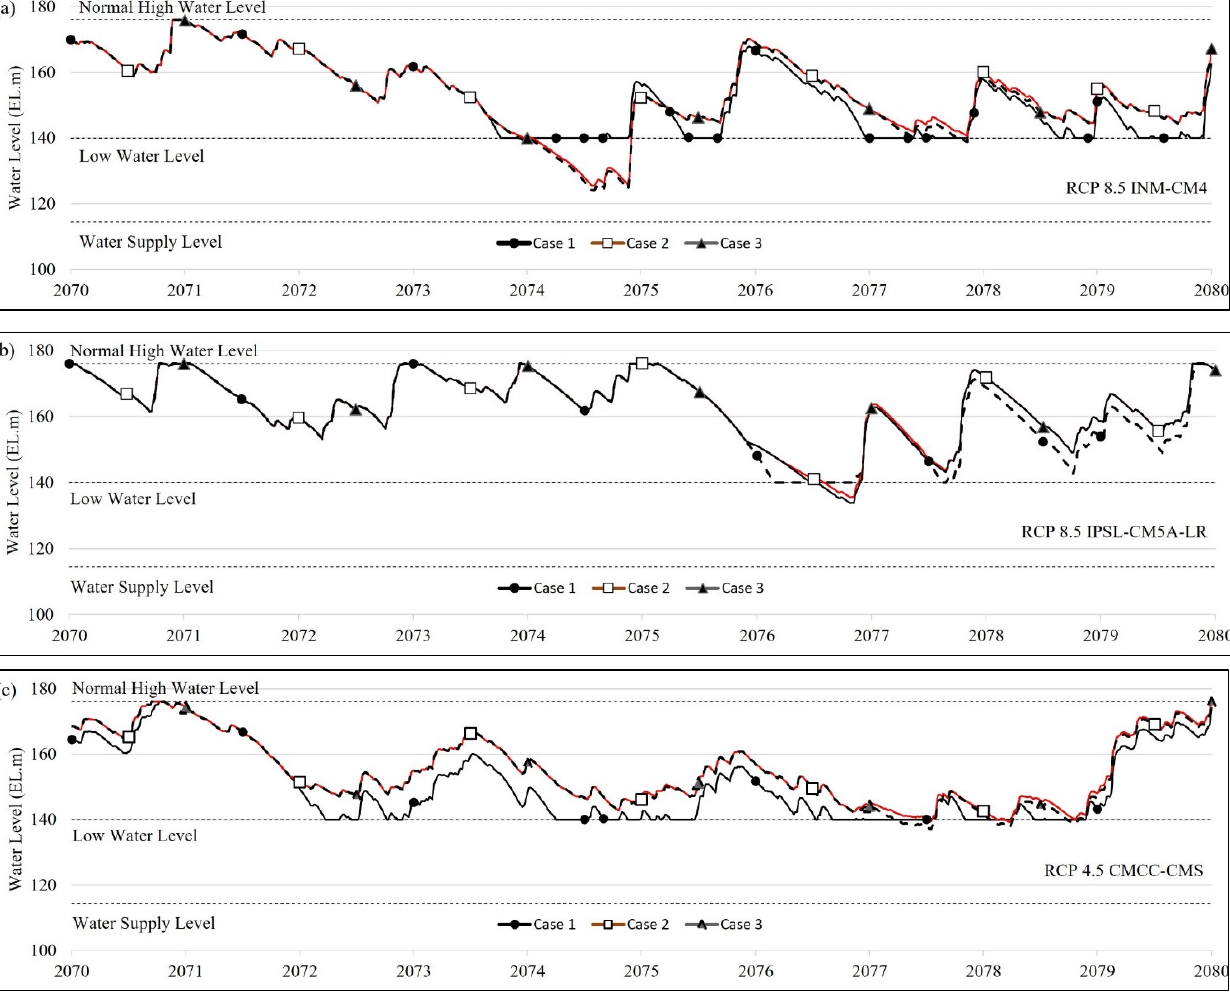
Figure 8. Changing water level in Gunwi reservoir for Case 1, Case 2, and Case 3 in Scenario RCP 8.5 INM-CM4 ( a ), RCP 8.5 IPSL-CM5A-LR ( b ), and RCP 4.5 CMCC-CMS ( c ) from 2070 to 2080. 5. Conclusions As climate change exacerbates, the current reservoir storage in South Korea is insuf- ficient to meet the water demand. No study has yet evaluated the effects of activating the reservoir emergency storage in response to upcoming extreme drought. The scientific value of this study is assessing the effects of emergency storage and determining the